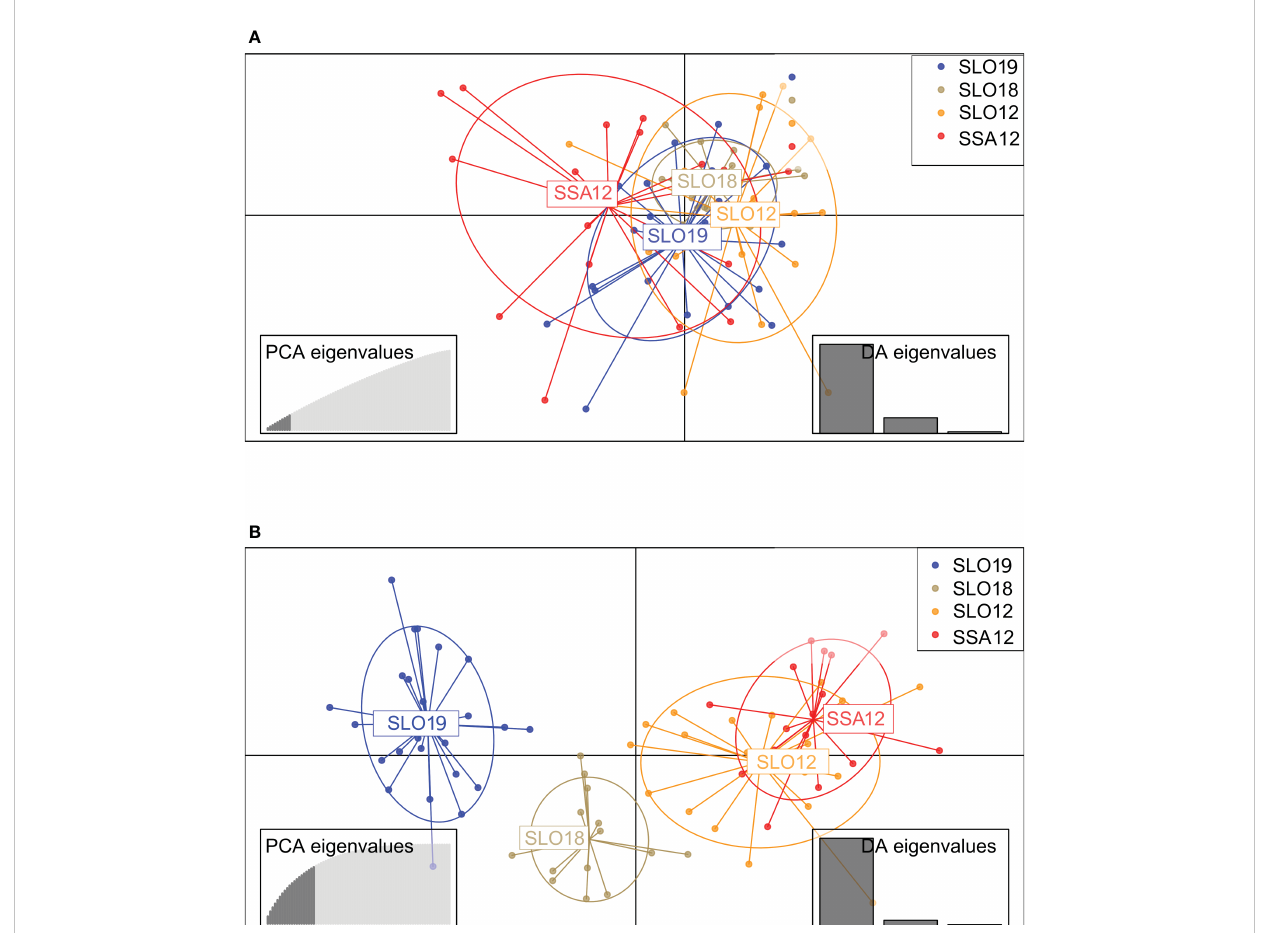
FIGURE 3 Discriminant Analysis of Principal Components (DAPC) plots of cockles Cerastoderma edule using: (A) neutral dataset (10 PCs; 18% of variance explained); (B) 110 PCAND dataset DAPC (20 PCs, 72% of explained variance). Codes are shown in Table 1. PCs retained according to the cross- validation method with the lowest RMSE are shown at the left bottom of each